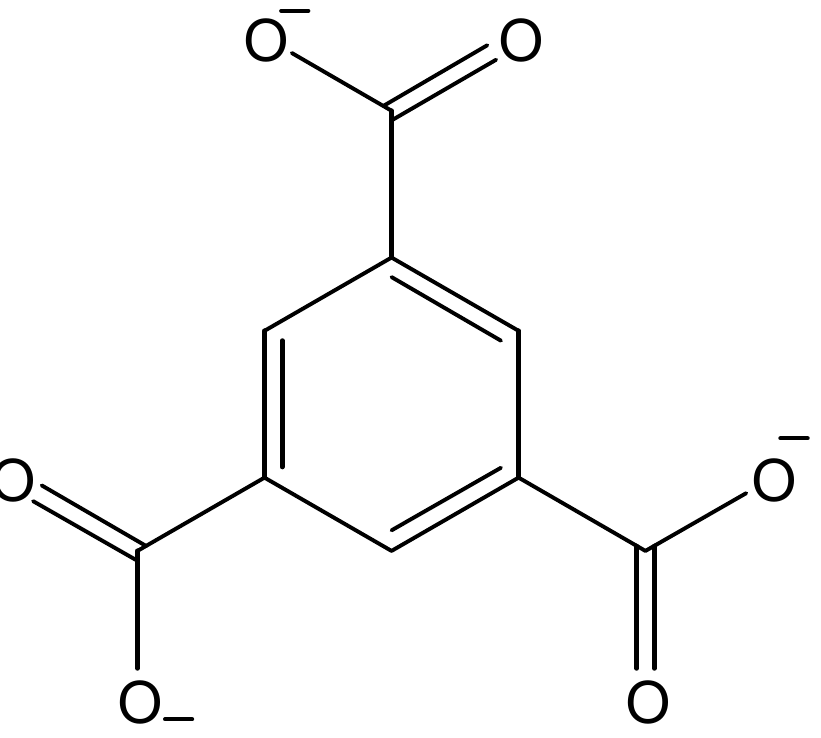
Figure 1. Structure of 1,3,5-benzenetricarboxylate .